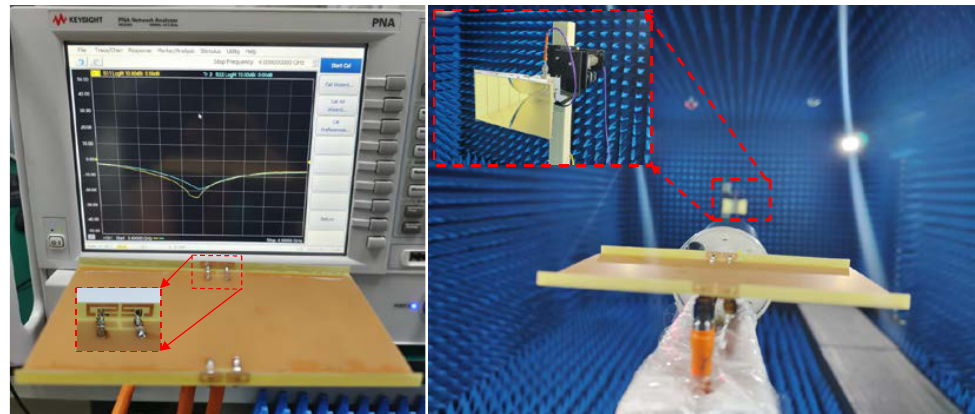
Figure 11. The fabricated model and experimental scene.